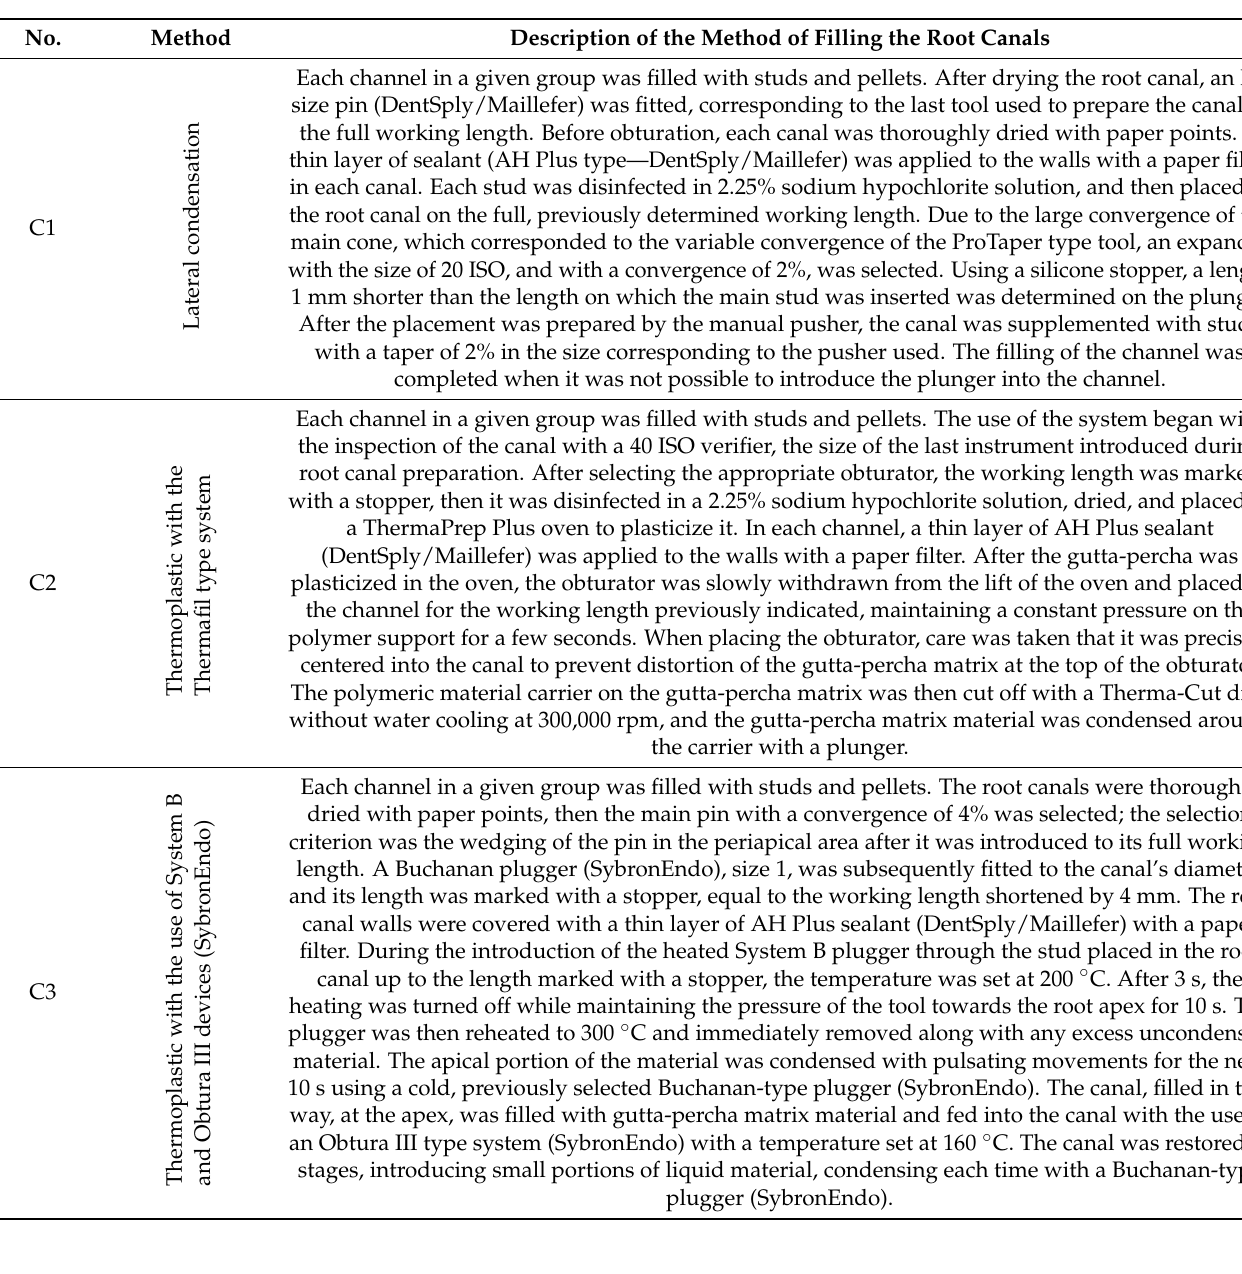
Table 3. Methods of root canal